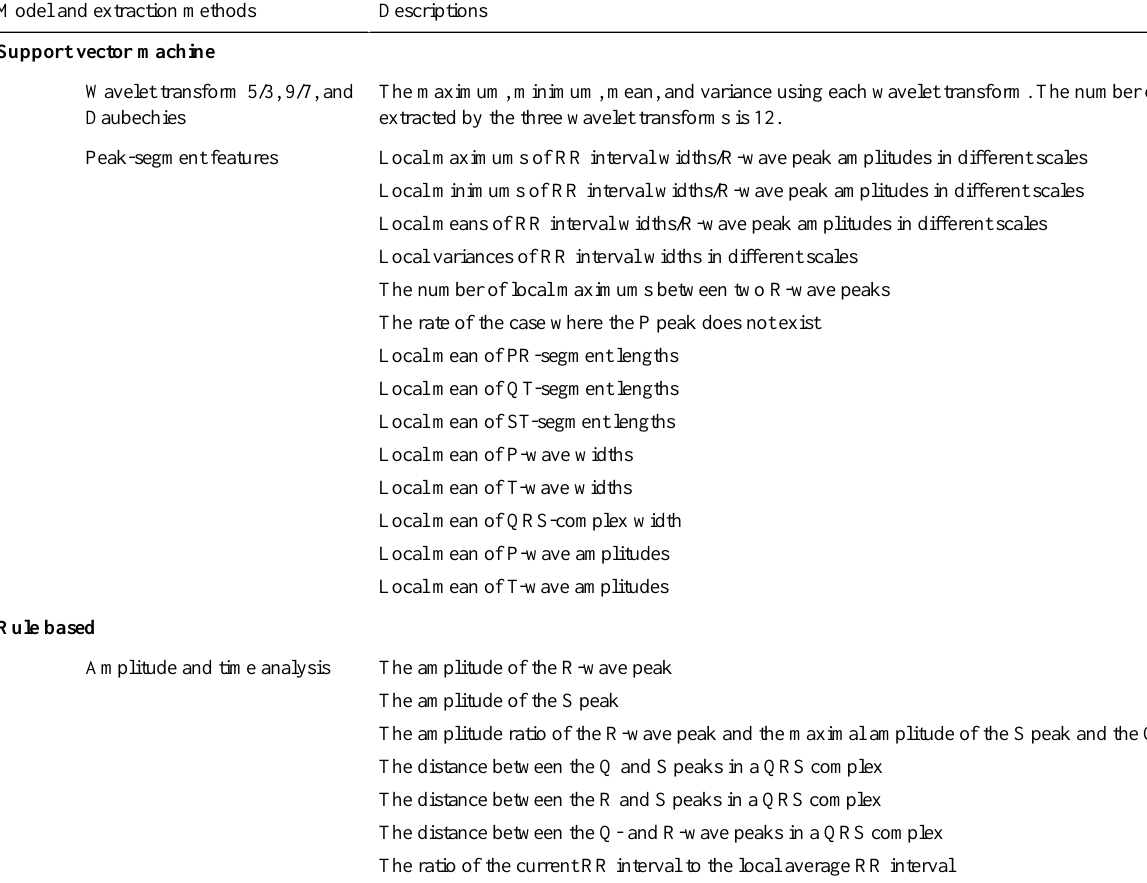
Table 1. Features of classifiers. DescriptionsModel and extraction